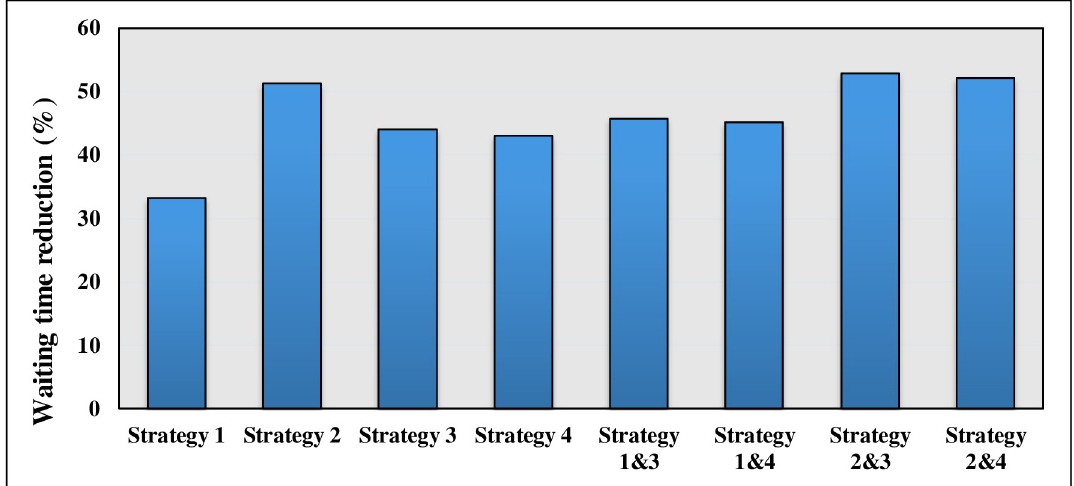
Fig 10. Comparison of the impact of different strategies on waiting time.